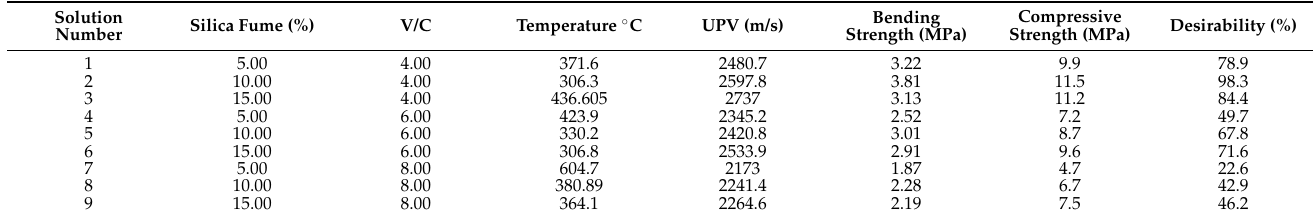
Table 8. Optimization with desirability